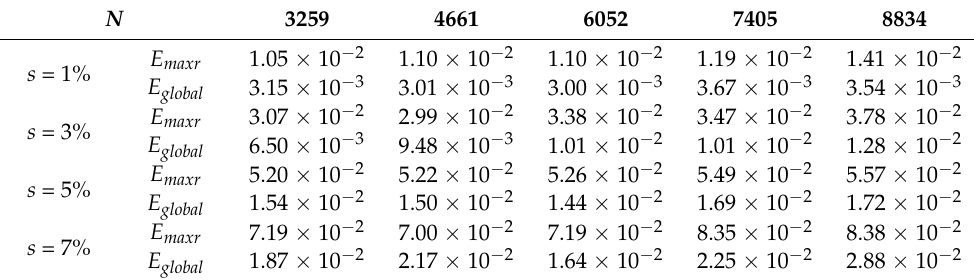
Table 5. The numerical errors with different number of total nodes.